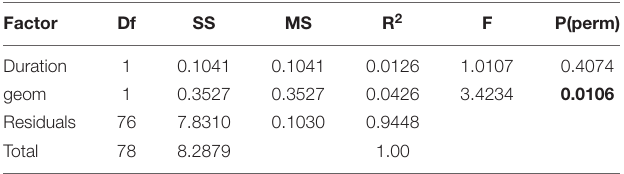
TABLE 1 | Permutational multivariate analysis of variance (PERMANOVA) of the influence of seabed geomorphology on the structure of pelagic